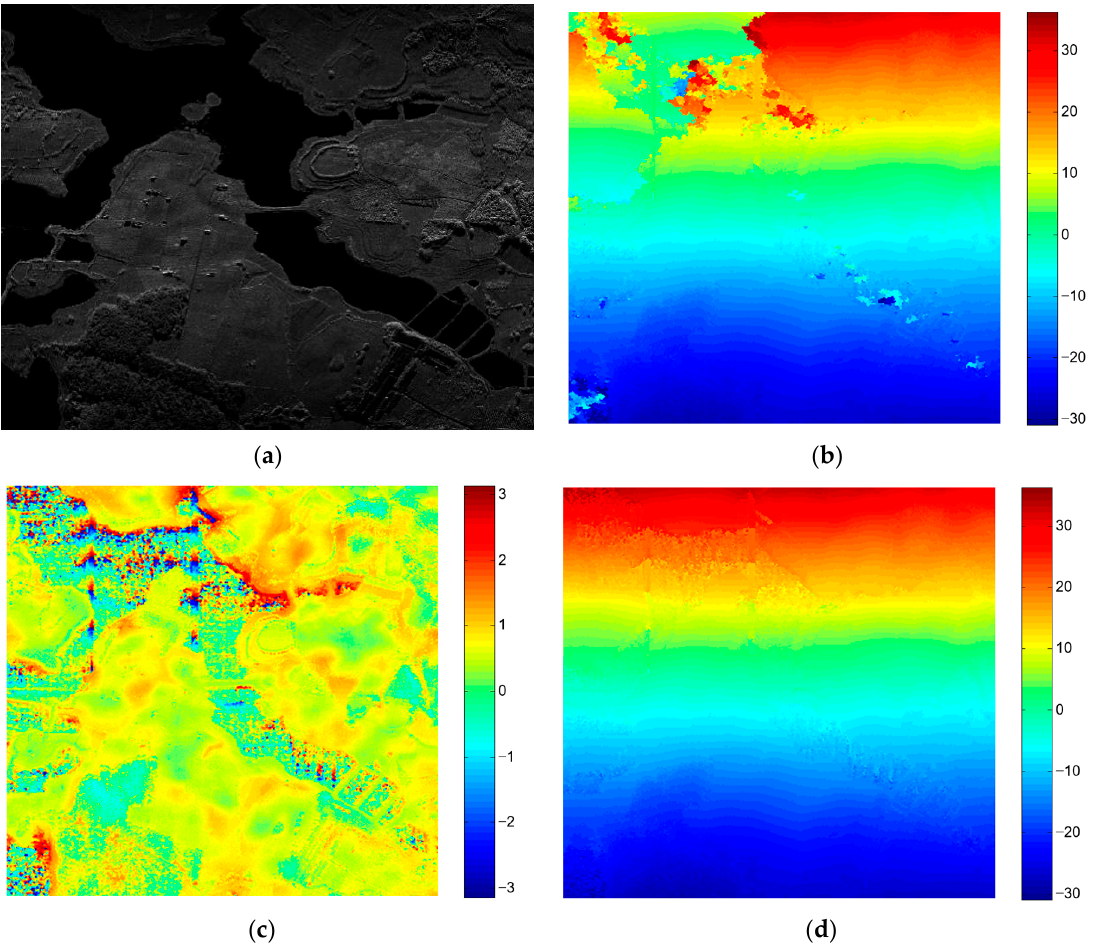
Figure 23. Phase processing of data block containing water area, where ( a ) is the amplitude image, ( b ) is the result of conventional phase unwrapping, ( c ) is the result of removing the rough terrain (SRTM) phase, and ( d ) is the correct phase unwrapping result.